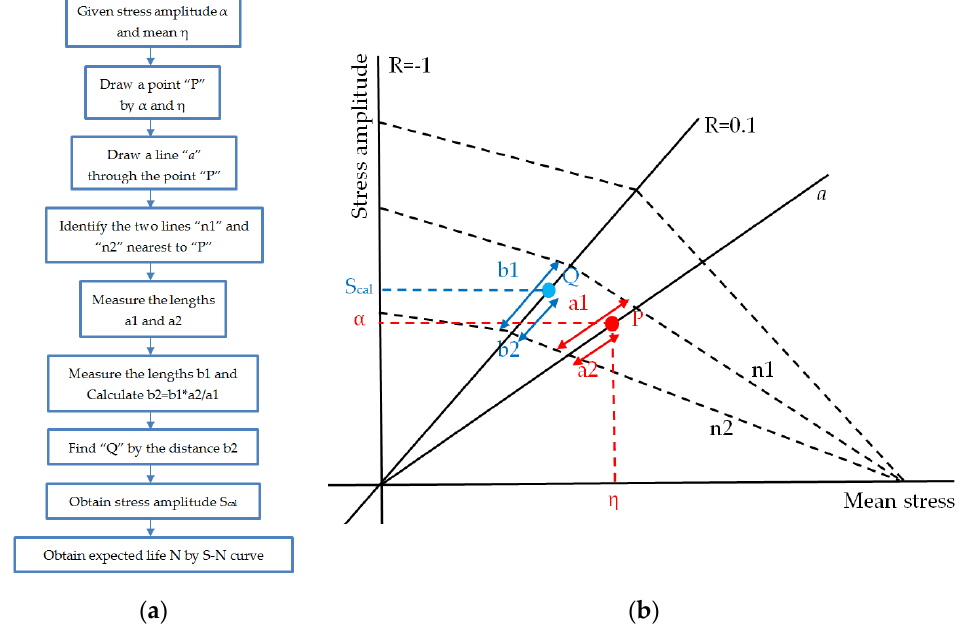
Figure 8. Schematic of a constant-amplitude life diagram: ( a ) Flow chart of the interpolation method; ( b ) Constant-amplitude life diagram.